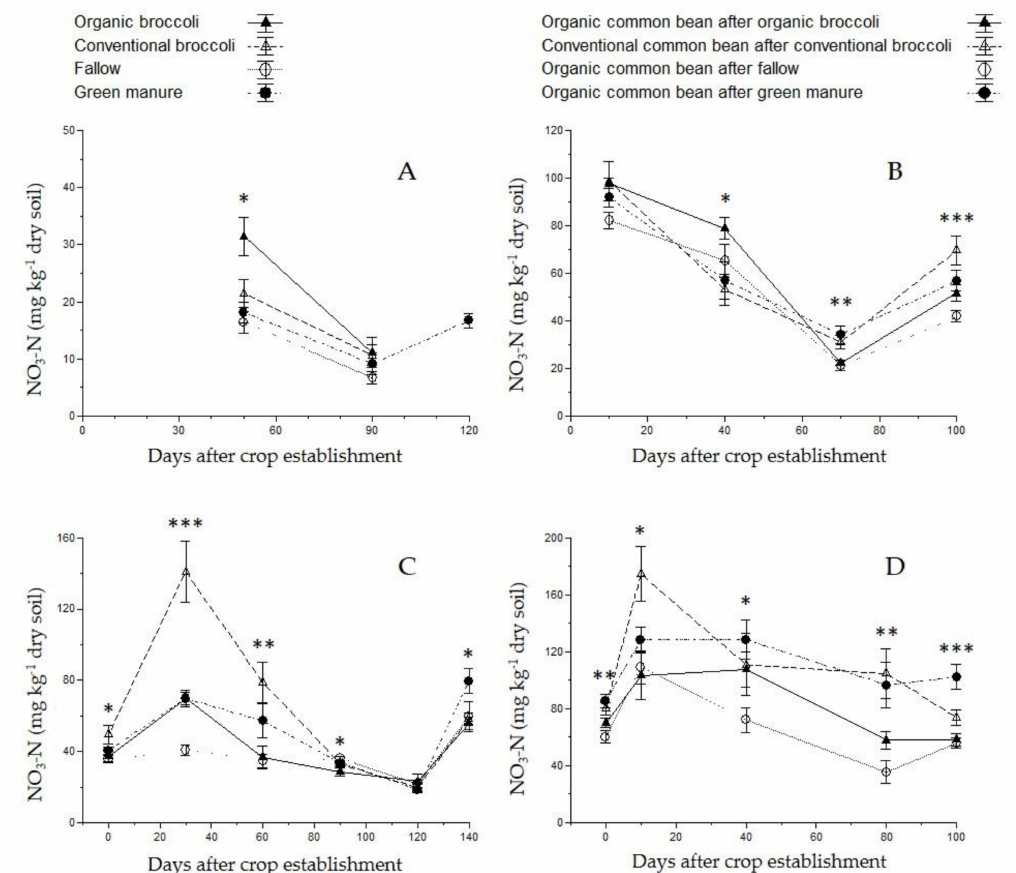
Figure 5. Impact of pre-crop treatments during the wintertime on NO 3 -N concentration in the soil during the two experimental years. Vertical bars indicate standard errors of means (n = 8), while *, **, and *** indicate significant di ff erences according to Duncan’s multiple range test ( p < 0.05) at p < 0.05, p < 0.01, and p < 0.001, respectively. ( A ) Soil NO 3 -N concentrations in the di ff erent treatments applied as preceding crops during autumn-winter 2017–2018, particularly at 50, 90, and 120 days after crop establishment (DACE). ( B ) Soil NO 3 -N concentrations after crop establishment, at the 50% flowering stage, during harvest, and at crop termination (10, 40, 70, and 100 DACE) in the common bean crop during spring-summer 2018, as influenced by the preceding winter crop. ( C ) Soil NO 3 -N concentrations before basal dressing, after crop establishment, at the stage of broccoli flower head formation, at crop termination of broccoli, at 50% flowering of faba bean, and after incorporation of plant residues into the soil (0, 30, 60, 90, 120, and 140 DACE) in the di ff erent treatments applied as preceding crops during autumn-winter 2018-2019. ( D ) Soil NO 3 -N concentrations before and after the establishment of common bean crop, at the 50% flowering stage, at harvest, and at crop termination (0, 10, 40, 80, and 100 DACE, respectively) during spring-summer 2019, as influenced by the preceding winter